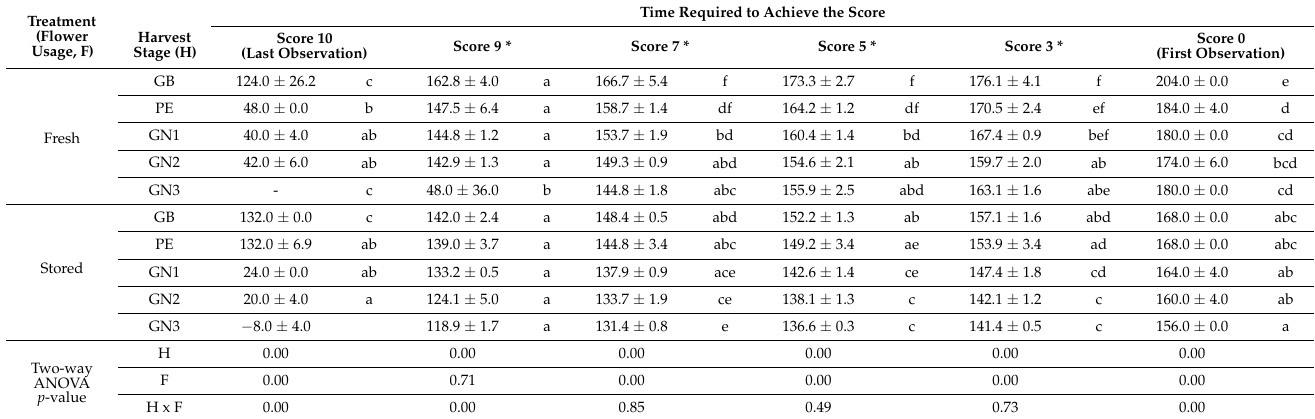
The different letters next to the mean and standard deviation represent the difference between the treatments at the p < 0.05 level. * Interpolated data (by linear